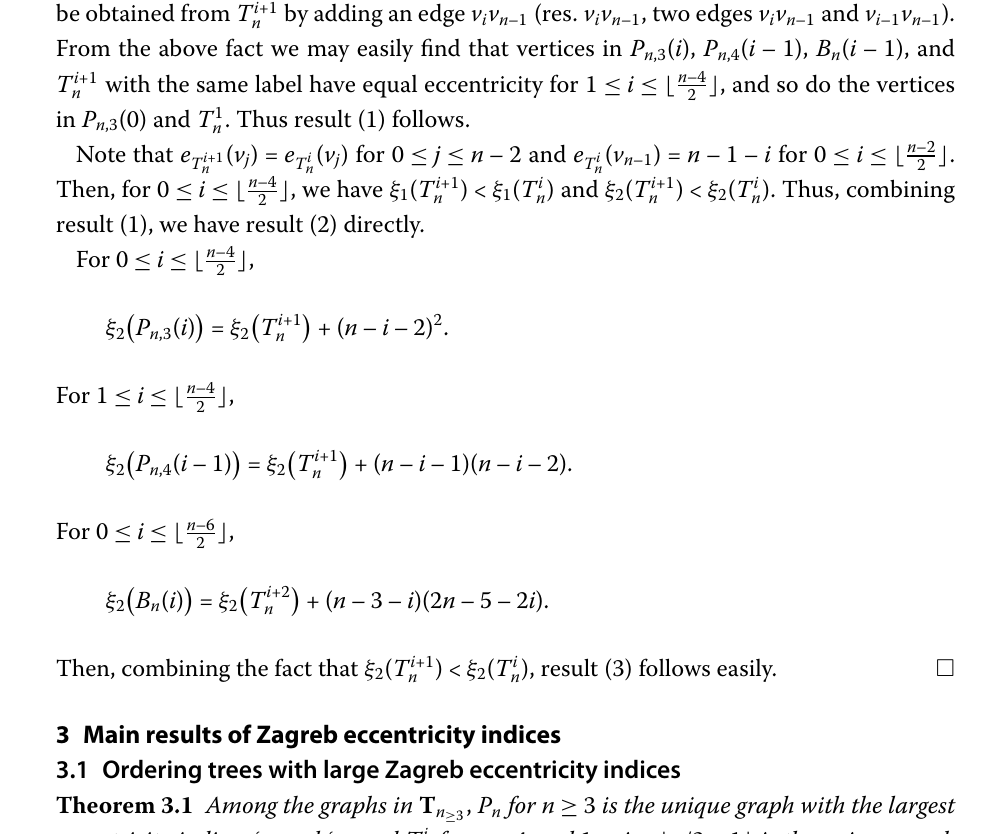
Figure 3 The graph P n ,4 ( i )